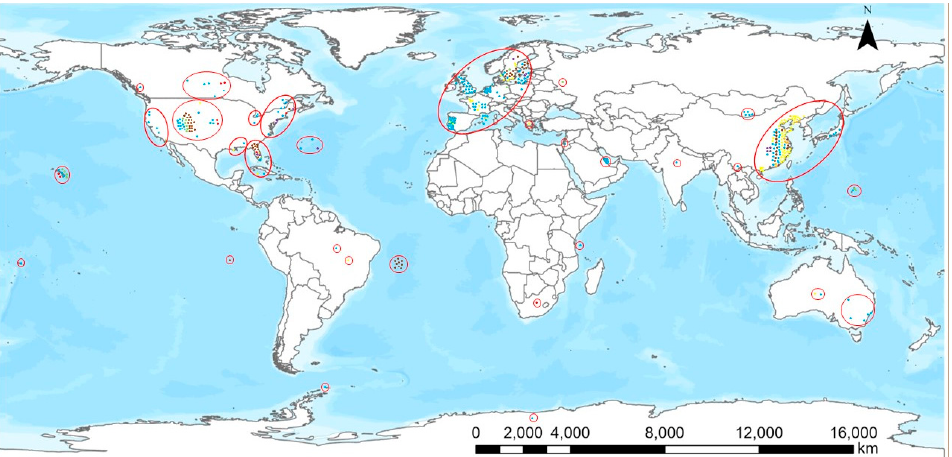
Figure 1. Geographical distribution of the occurrence of BMAA and its isomers. Color coding of the dots: phytoplankton and zooplankton, blue; plants, green; bivalvia, yellow; gastropoda, orange; crustacea, purple; fish, brown; mammals, red.